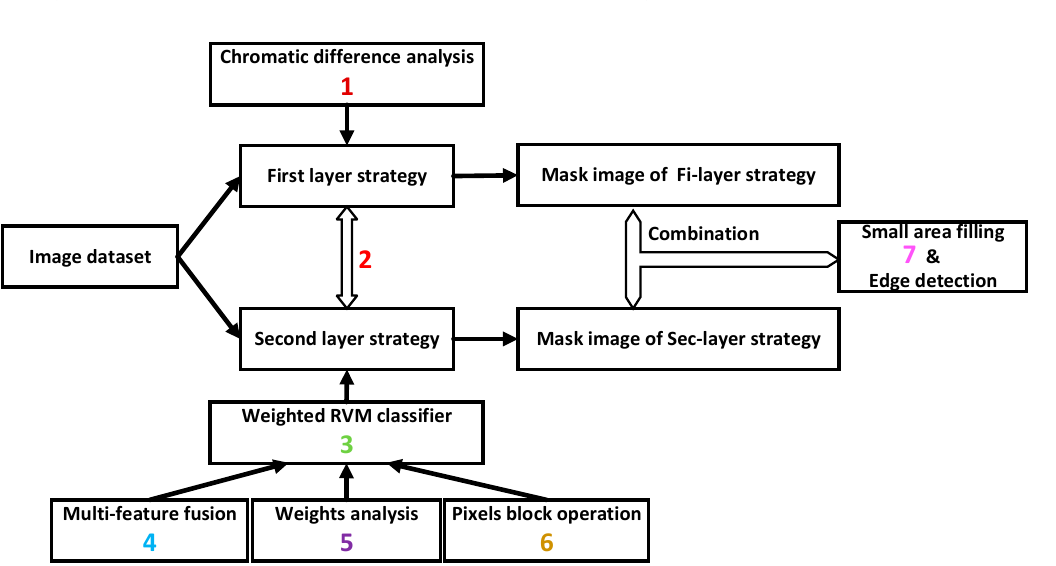
Figure 2. Advantages analysis flowchart of our proposed algorithm.